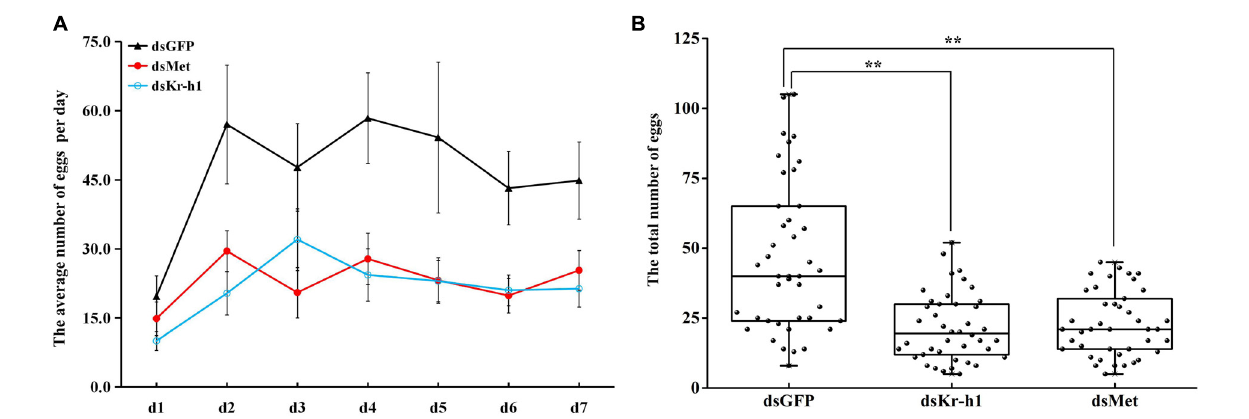
FIGURE 5 | Effects of Met and Kr-h1 RNAi on fecundity in B. dorsalis . (A) The average number of eggs per day recorded continuously for 7 day after successful mating. Error bars represent the SE of the calculated means based on the six replicates. (B) The total number of eggs for 7 days after Met and Kr-h1 RNAi. Every dot means the total number eggs of four female adults. The asterisks indicate statistically significant difference between treatment and control group ( ∗ P < 0.05; ∗∗ P < 0.01).